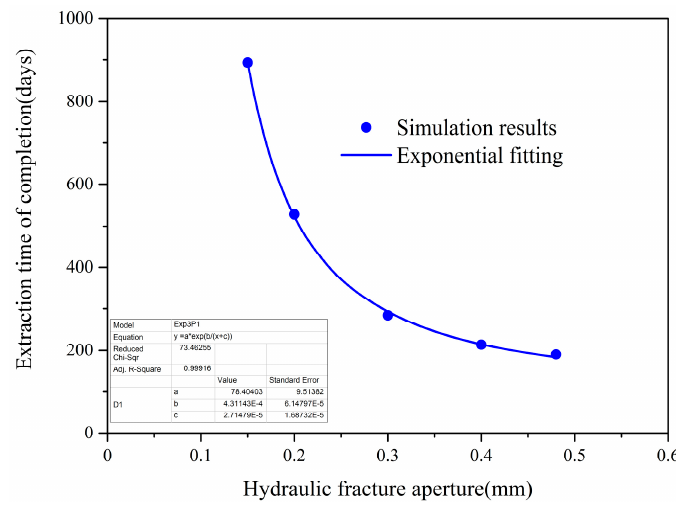
Figure 12. Effect of initial hydraulic fracture aperture on extraction time of completion.